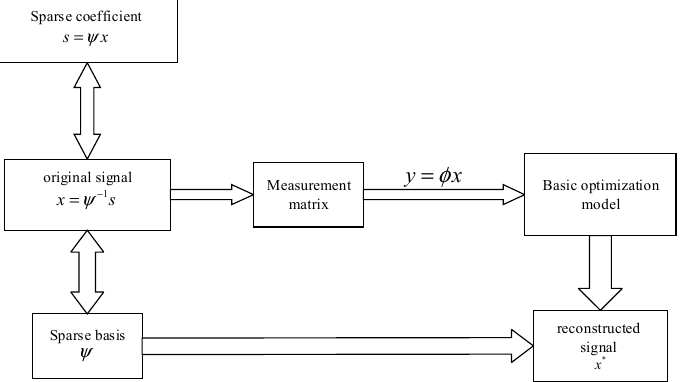
Figure 1. Basic framework of compressed sensing. ( x denotes the original signal, and the x * denotes the reconstructed signal )